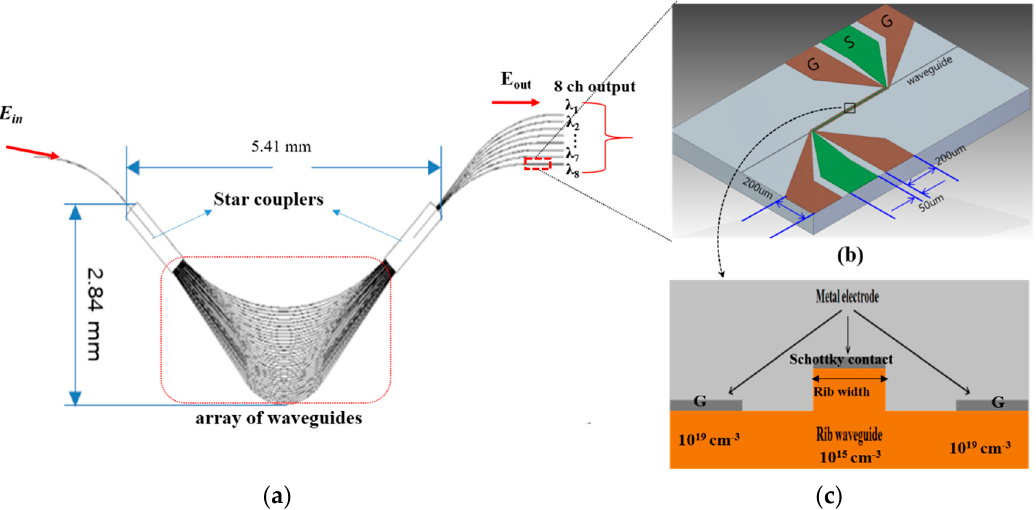
Figure 2. ( a ) Schematic view of 1 × 8 channel silicon transmitter with electro-absorption modulators (EAMs); ( b ) top view of the silicon EAM with coplanar waveguide (CPW); ( c ) cross-section view of the EAM.